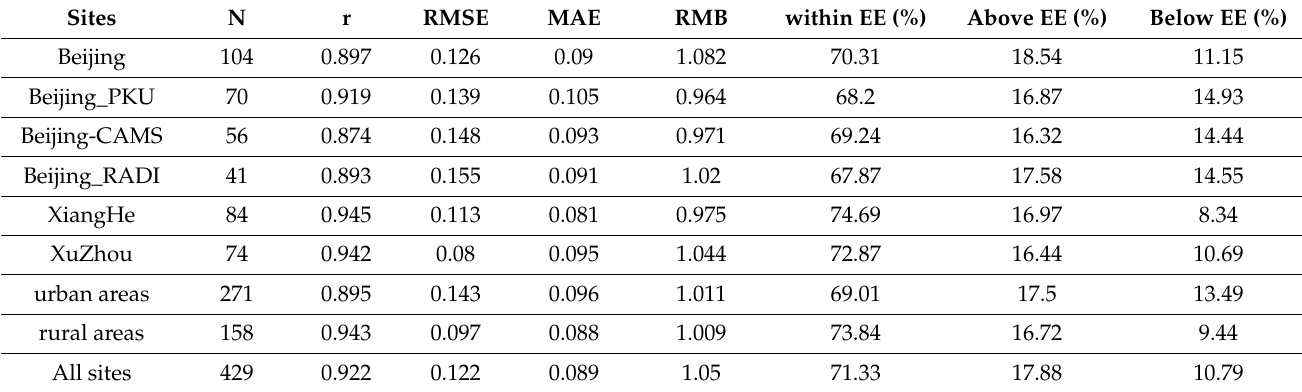
Table 3. Comparison of accuracy between GF-4 AOD and AERONETAOD in different regions.